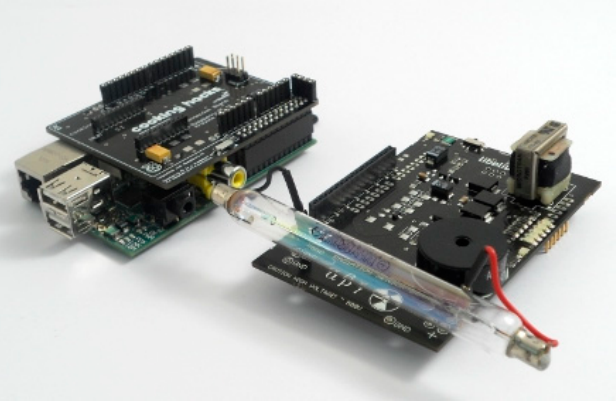
Figure 3. Raspberry Pi and Geiger Sensor ( left ) connected to the Bridge board and the Geiger Sensor board ( right ).